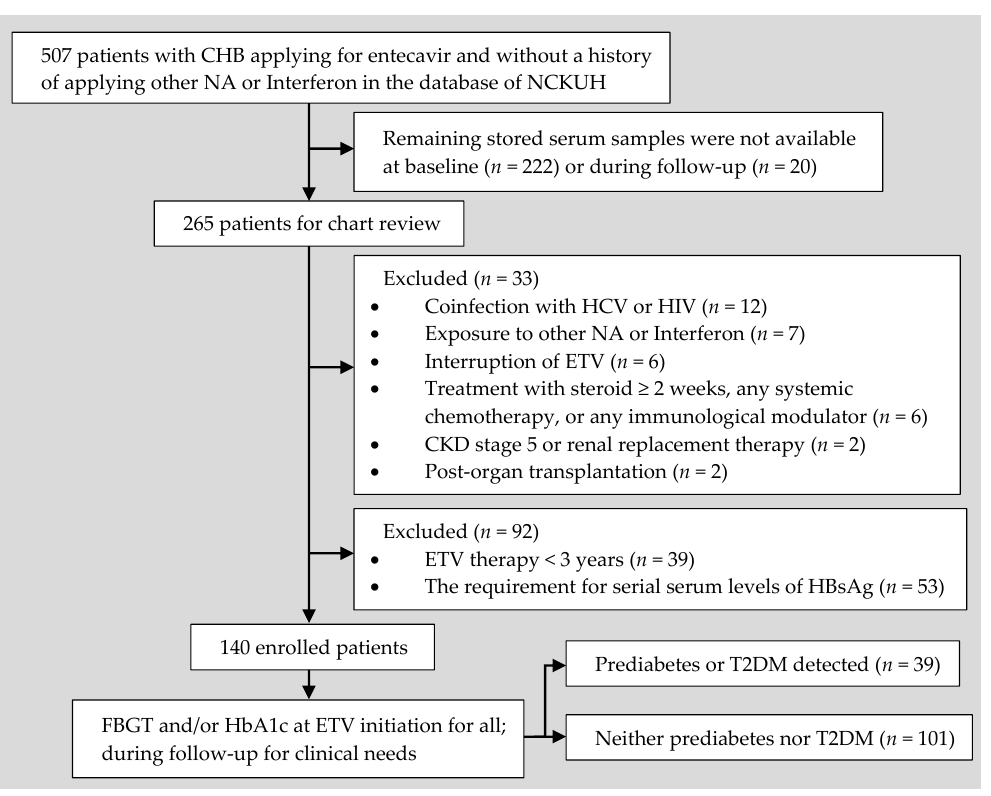
Figure 1. Patient disposition. CHB, chronic hepatitis B; CKD, chronic kidney disease; ETV, entecavir; FBGT, fasting blood glucose test; HbA1c, hemoglobin A1C; HBsAg, hepatitis B surface antigen; HCV, hepatitis C virus; HIV, human immunodeficiency virus; NA, nucleos(t)ide analogs; NCKUH, National Cheng Kung University Hospital; T2DM, type 2 diabetes mellitus.